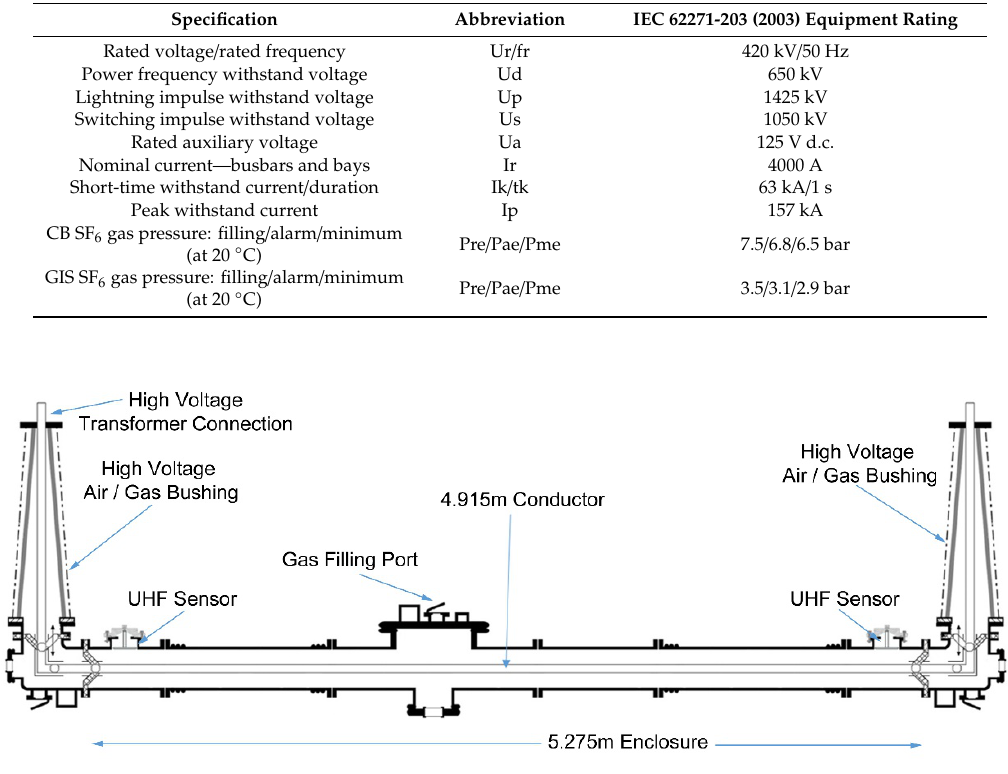
Figure 2. Gas insulated line demonstrator sections and dimensions.